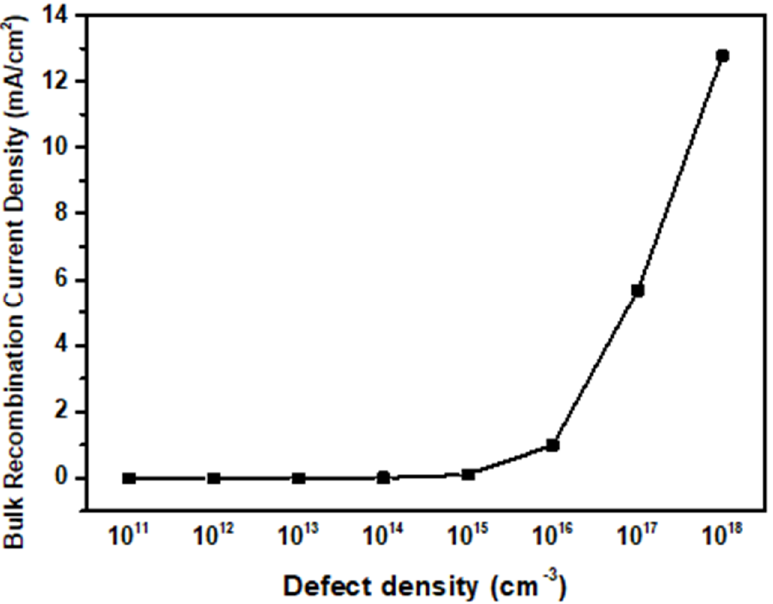
Figure 10. Recombination current density with varying PAL defect densities.